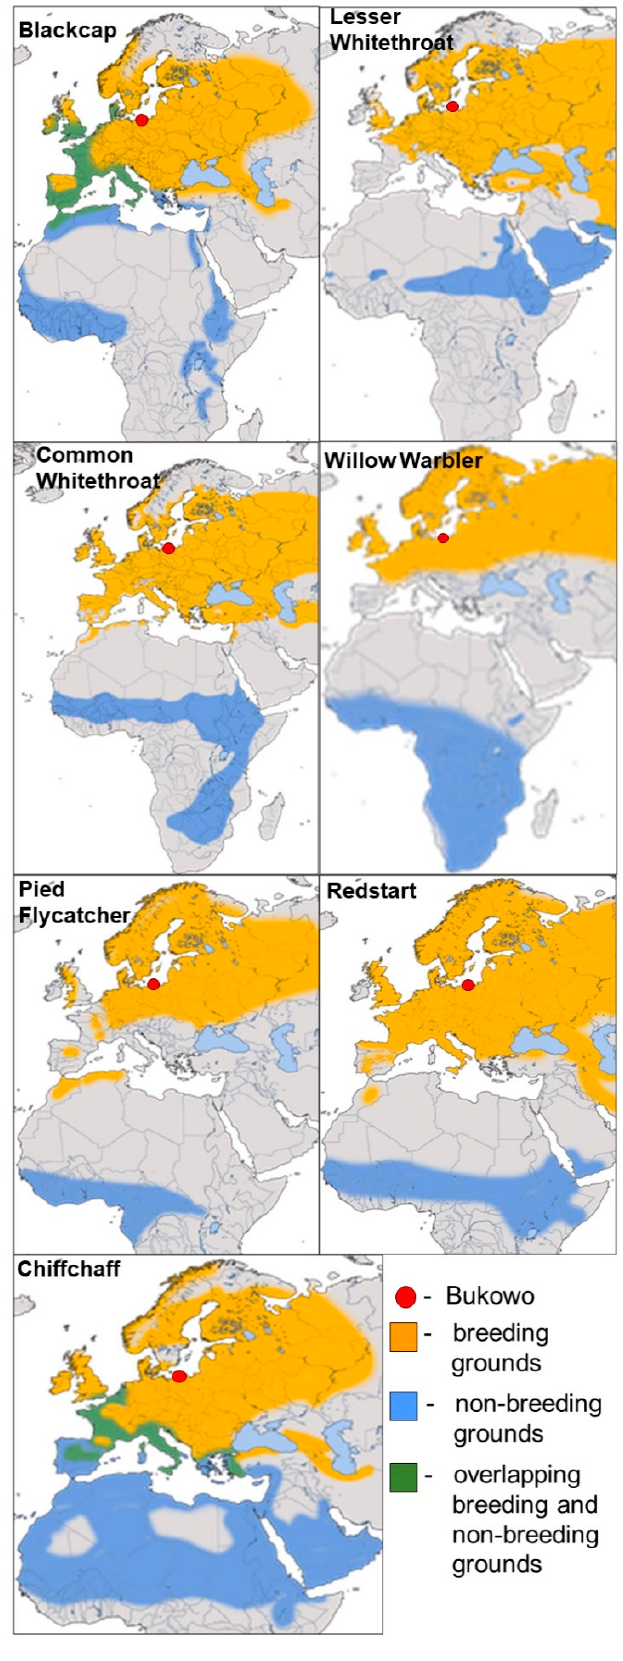
Figure 1. Geographical ranges for the seven long-distance migrants we analysed in the study. Maps by Andreas Trepte after [55], modified.